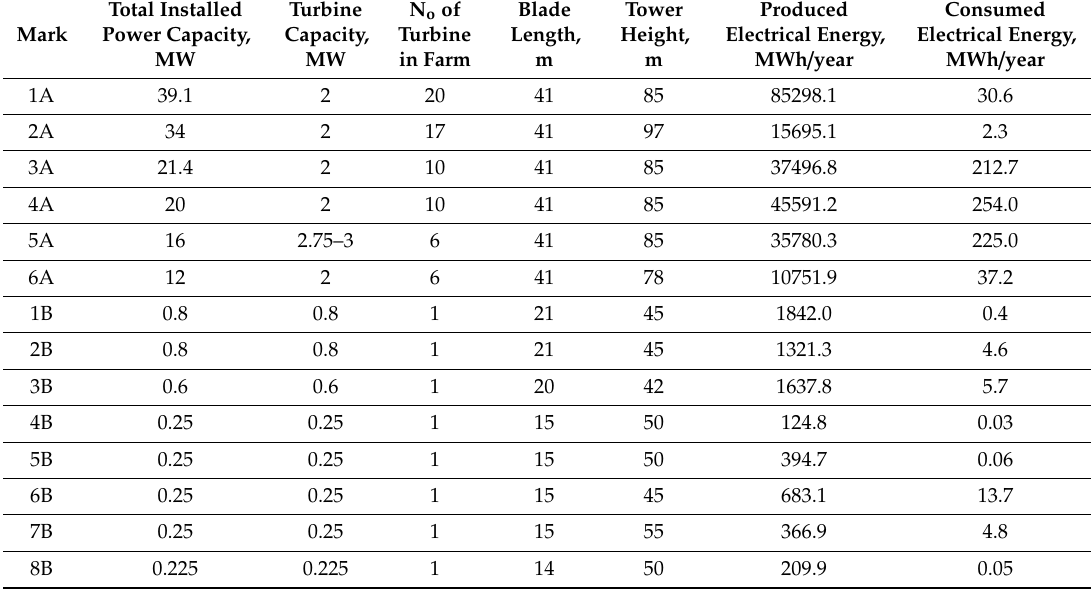
Table 3. The main characteristics of the investigated wind